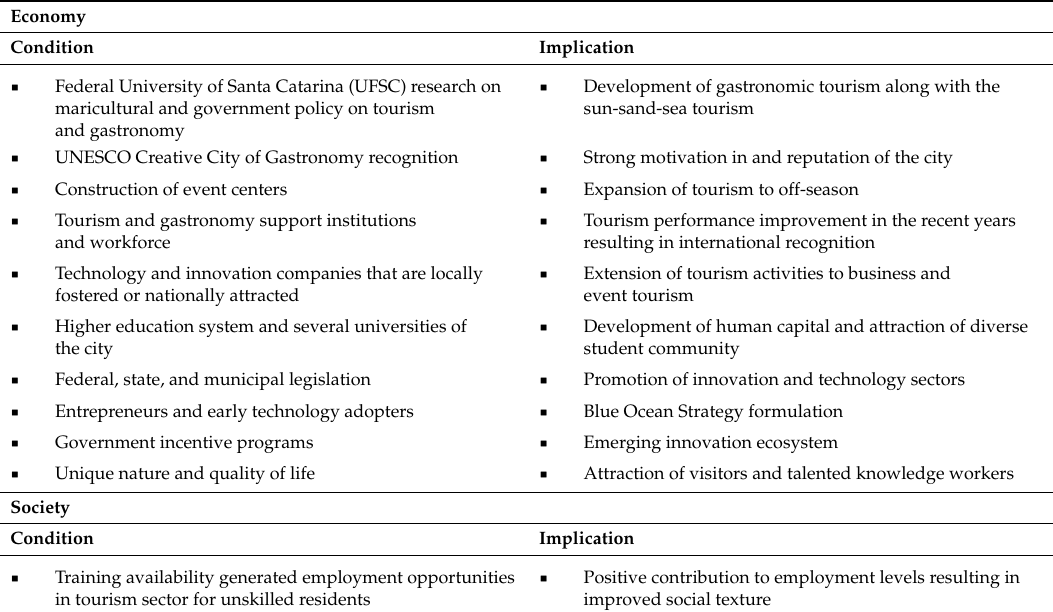
Table 3. Florianopolis’ knowledge-based urban development